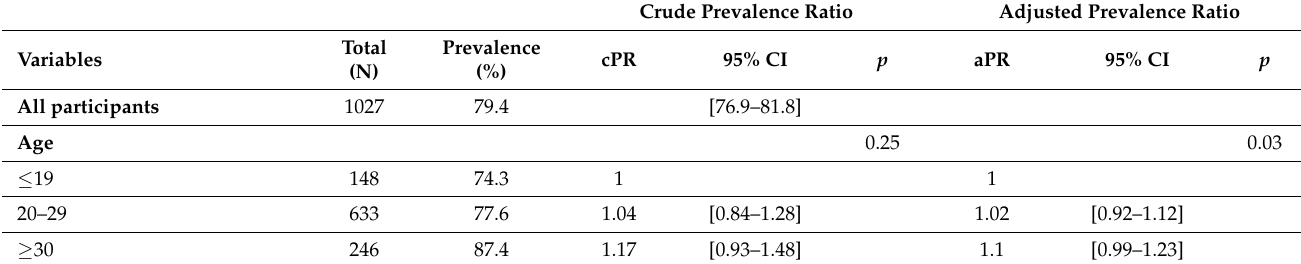
Table 4. Inadequate physical activity among pregnant women and associated factors in rural and semi-urban Burkina Faso, 2019; (Crude, Adjusted prevalence ratio, and 95%